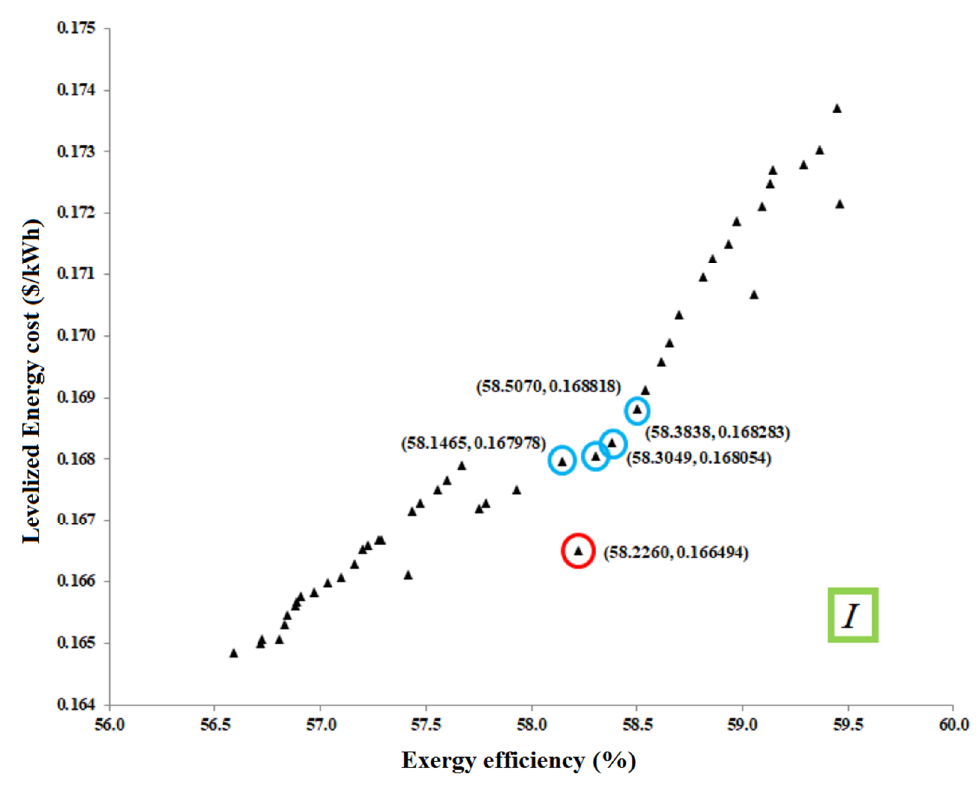
Figure 8. the Pareto frontier solutions in the objective space for model 3 with three different working fluids, pure Pentane, pure R24fa and the combined Pentane[0.6]/R24fa[0.4].